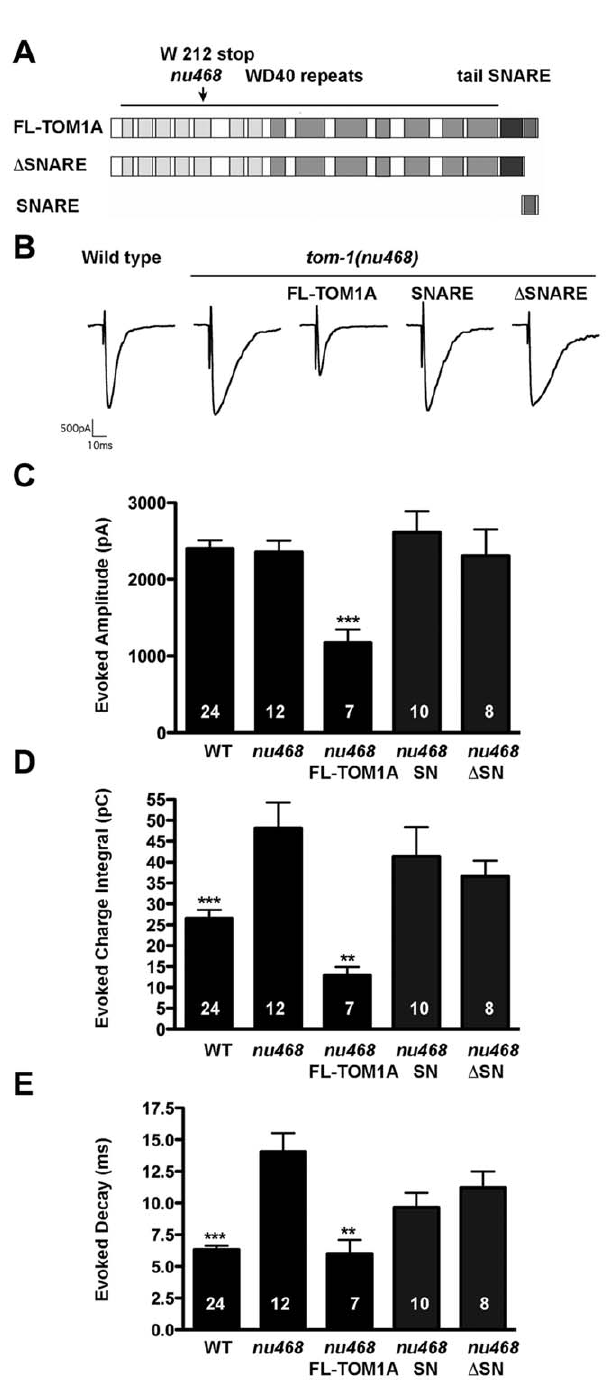
Figure 2. SNARE and D SNARE domains of TOM-1A fail to rescue tom-1(nu468) mutants. A. Schematic showing full-length TOM-1A (SY1242) and the SNARE (SY1230) and D SNARE (SY1231) truncated constructs used to generate the integrated transgenics. The position of the early stop at amino acid W212 for tom-1(nu46 8) is indicated by the arrow B. Representative traces of evoked post-synaptic responses and plots of evoked amplitude (***, p=0.006) ( C ), evoked charge integral (**,p = 0.0014, ***, p = 0.007) ( D ) and evoked half-time decay ((**,p=0.001, ***, p , 0.0001) ( E ). All data are expressed as mean 6 SEM. The Mann Whitney T-test was used to determine significance values relative to tom-1(nu468) . The sample size (n) is indicated as a number in each bar.